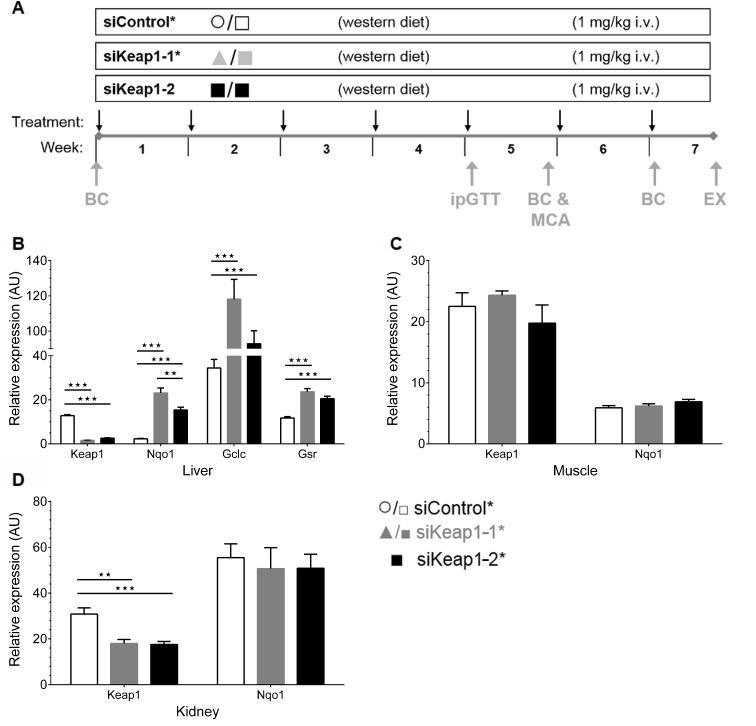
Keap1 inhibition and Nrf2 target gene regulation by liver-selective, Keap1-specific siRNAs in mice after siRNA and WD intervention.(A) Schematic of the long-term mouse experiment. (B) Hepatic Keap1 as well as Nrf2 target genes Nqo1, Gclc and Gsr expression (n = 11). (C) Relative mRNA expression of Keap1 and Nqo1 in muscle tissue of mice (fed, n = 6). (D) Expression levels of Keap1 and Nqo1 in kidney (fed, n = 6,). Data are represented as mean ± SEM. One-way ANOVA with Bonferroni's mct. ** p < 0.01, *** p < 0.001. Black arrows: Recording of body weight and siRNA injection, Grey arrows: Experimental procedures: BC: Analysis of body composition by 1H-nuclear magnetic resonance, EX: Sacrificing mice and organ preparation, ipGTT: intraperitoneal glucose tolerance test, MCA: Metabolic cage analysis.